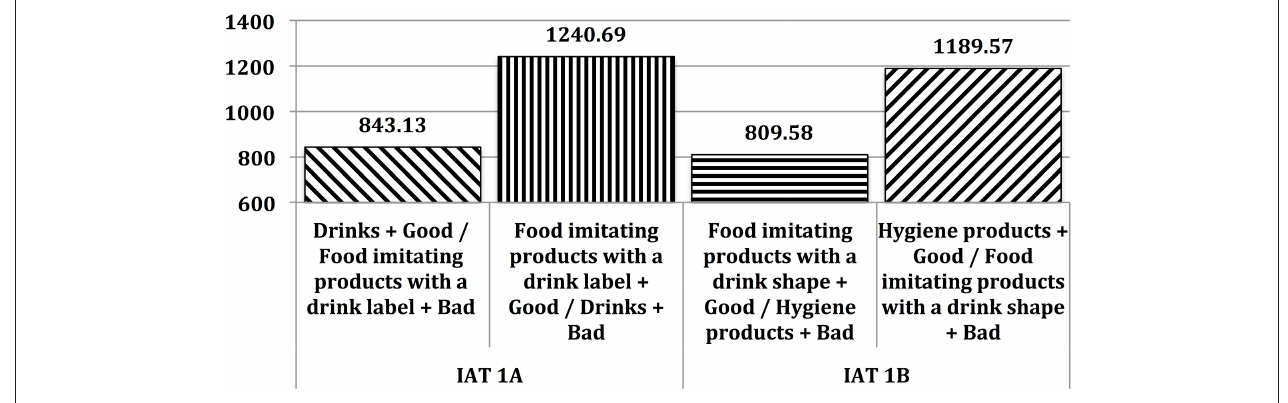
FIGURE 2 | Mean response latencies (in milliseconds) in Study